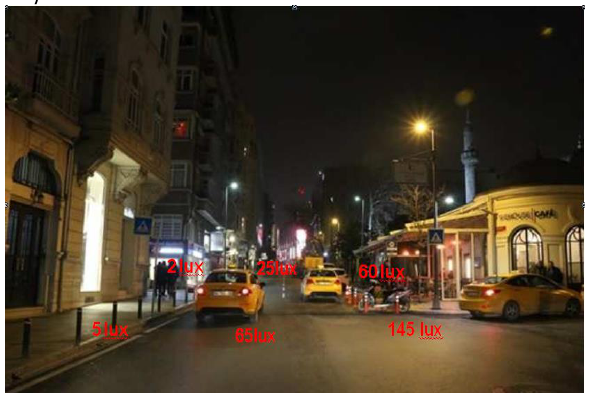
Figure 12. Measurement results